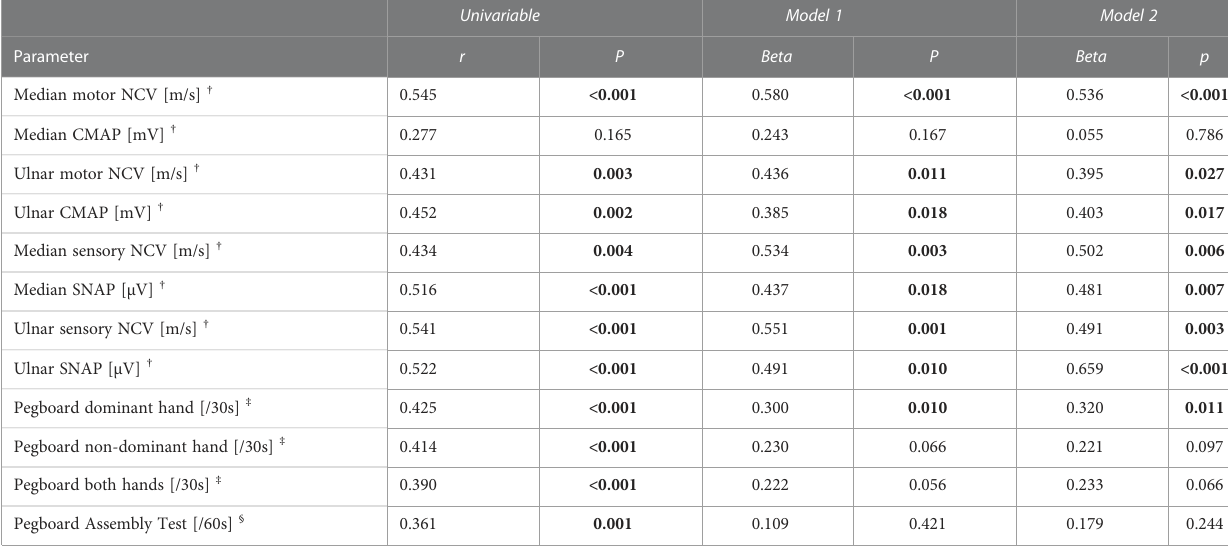
TABLE 3 Correlations of sciatic nerve´s FA (dependent variable) with nerve conduction studies and functional parameters of the upper limb participants (independent variables) for all study participants.